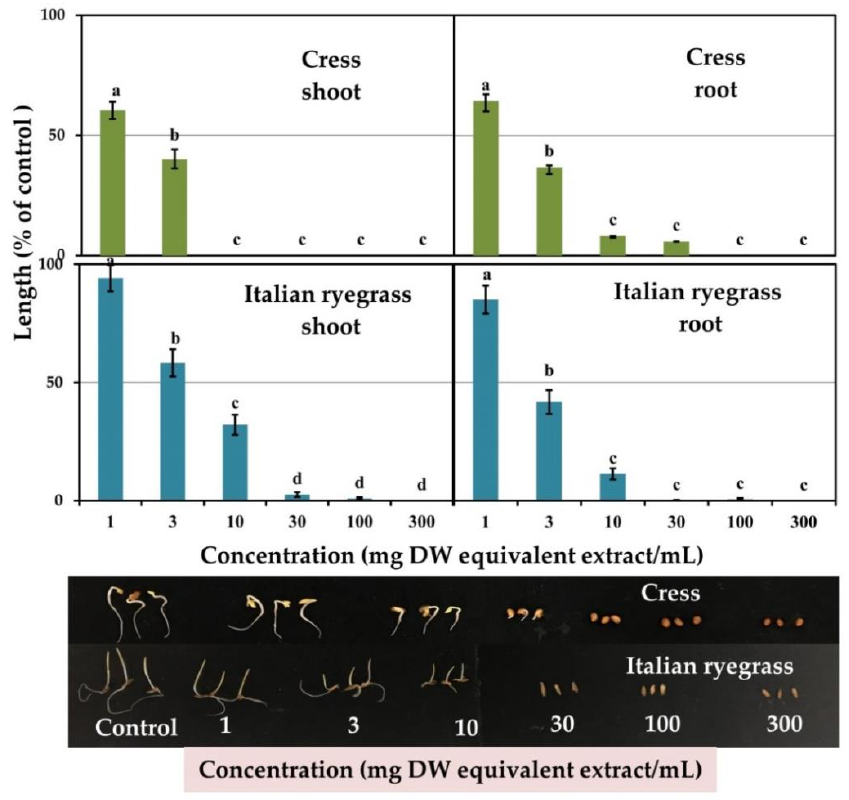
Figure 2. Inhibitory effects of aqueous methanol extracts of Marsdenia tenacissima on the seedling growth of cress and Italian ryegrass with six concentrations. The bars on each experiment show mean ± SE. Different letters indicate significant differences among the treatments (Tukey’s HSD, p < 0.05). Italian ryegrass varied from 1.7 to 4.6 mg DW equivalent extract/mL, respectively (Table 1).